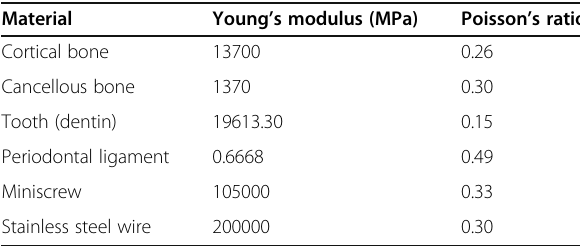
Table 1 Young ’ s modulus and Poisson ’ s ratio for various